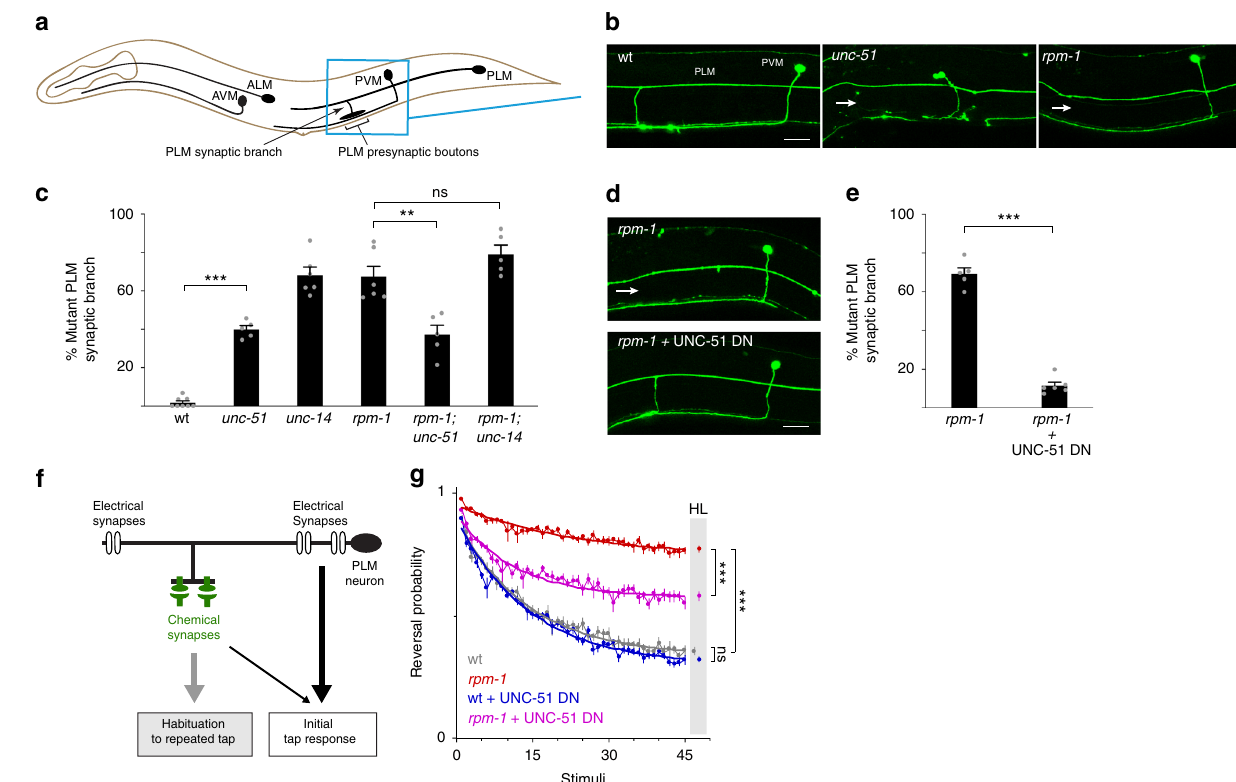
Fig. 3 unc-51 (lf) and UNC-51 DN expression suppress synapse maintenance defects in rpm-1 mutants. a Schematic of C. elegans mechanosensory neurons. Blue box highlights collateral synaptic branch and presynaptic boutons of PLM neurons imaged using confocal microscopy. PVM neuron is not PLM synaptic target, but is an anatomical marker for branch and bouton position. b Representative images of synaptic branch and presynaptic boutons for PLM neurons of indicated genotypes. Arrow indicates synapse maintenance defects, in which synaptic branch is retracted in rpm-1 mutants 46 . Absence of synaptic branch also occurs in unc-51 mutants. c Quantitation of synapse maintenance defects for indicated genotypes. Frequency of defects in rpm-1; unc- 51 double mutants is suppressed to levels in unc-51 single mutants. Suppression does not occur in rpm-1; unc-14 double mutants. d Representative images showing synapse maintenance defects (arrow) in rpm-1 mutants are suppressed when UNC-51 DN is expressed using MosSCI. e Quantitation shows synapse maintenance defects in rpm-1 mutants are suppressed by UNC-51 DN. f Summary of chemical and electrical synapses in PLM neurons that contribute to tap response and behavioral habituation. Loss of chemical synapses primarily affects habituation to repeated tap. g Multi-worm tracker quantitation of responses to repeated tap stimuli for indicated genotypes. Habituation defects in rpm-1 mutants are suppressed by MosSCI expression of UNC-51 DN in mechanosensory neurons. For synapse maintenance, means are shown from 5 to 8 counts (25 – 35 animals/count) for each genotype, and error bars represent SEM. For habituation, means are from 16 plates (~50 animals per plate) for each genotype, error bars represent SEM, curves are best fi t exponentials, and habituation level (HL) is fi t at fi nal stimulus. Signi fi cance determined using Student ’ s t test with Bonferroni correction. ** p <